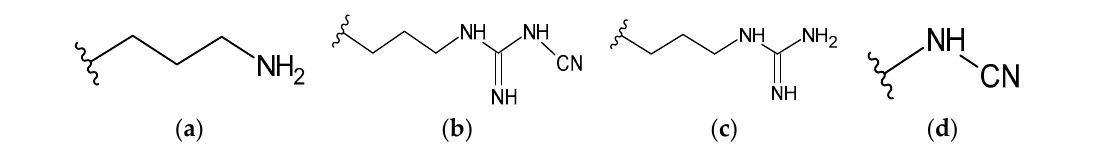
Figure 2. Synthesis of poly(hexamethylene biguanide) hydrochloride (PHMB.HCl) via polyconden- sation of 1,6-hexamethylenediamine and sodium dicyanamide. n = 2–42.